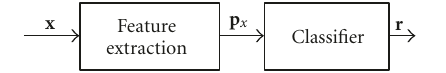
Figure 3: Standard paradigm for the classification of single and multiple